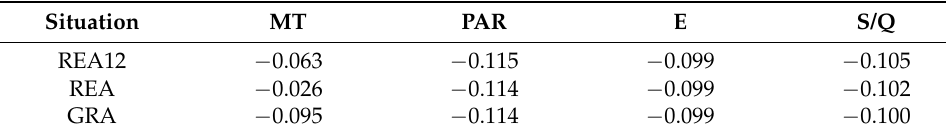
Table 9. The O 3 response rates with its driving factors considering monoterpene